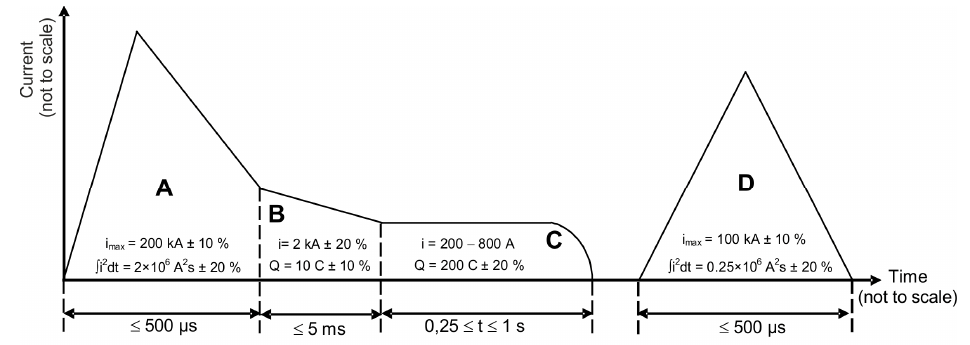
Figure 2. Current components A–D for direct lightning testing, adopted from [8].